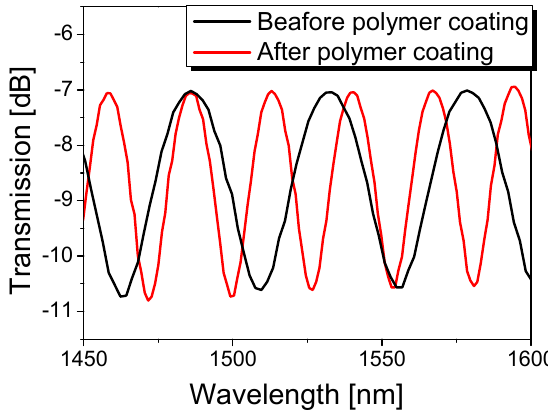
Figure 2. Interference spectrum of the polymer-overlaid microfiber MZI.